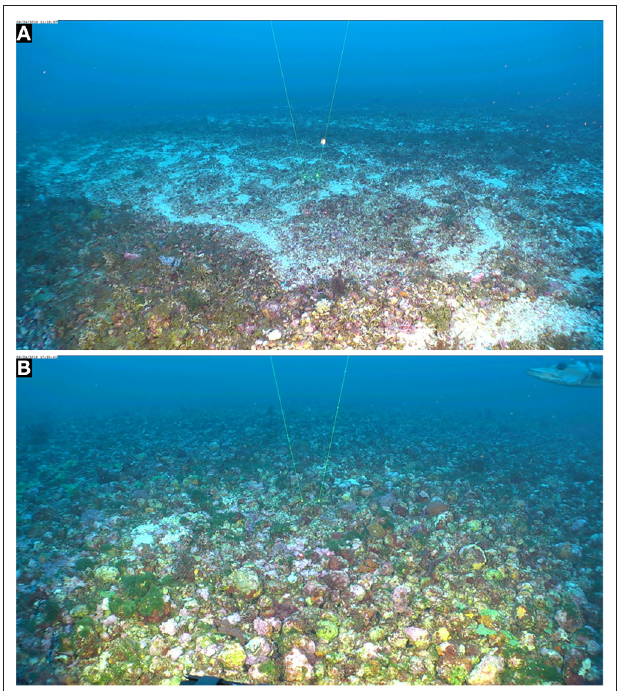
FIGURE 1 | Extensive rhodolith beds in East Flower Garden Bank, FGBNMS. Mohawk ROV photos taken on 24 Sept. 2018. (A) 27 ◦ 56’22.2288“N, 93 ◦ 36’1.3068”W, 53m (Dive 701_0905_111338). (B) 27 ◦ 54’4.6182“ N; 93 ◦ 36’40.2732” W, 52.9m (Dive 703_0603_172042). Space between spot lasers = 10cm.